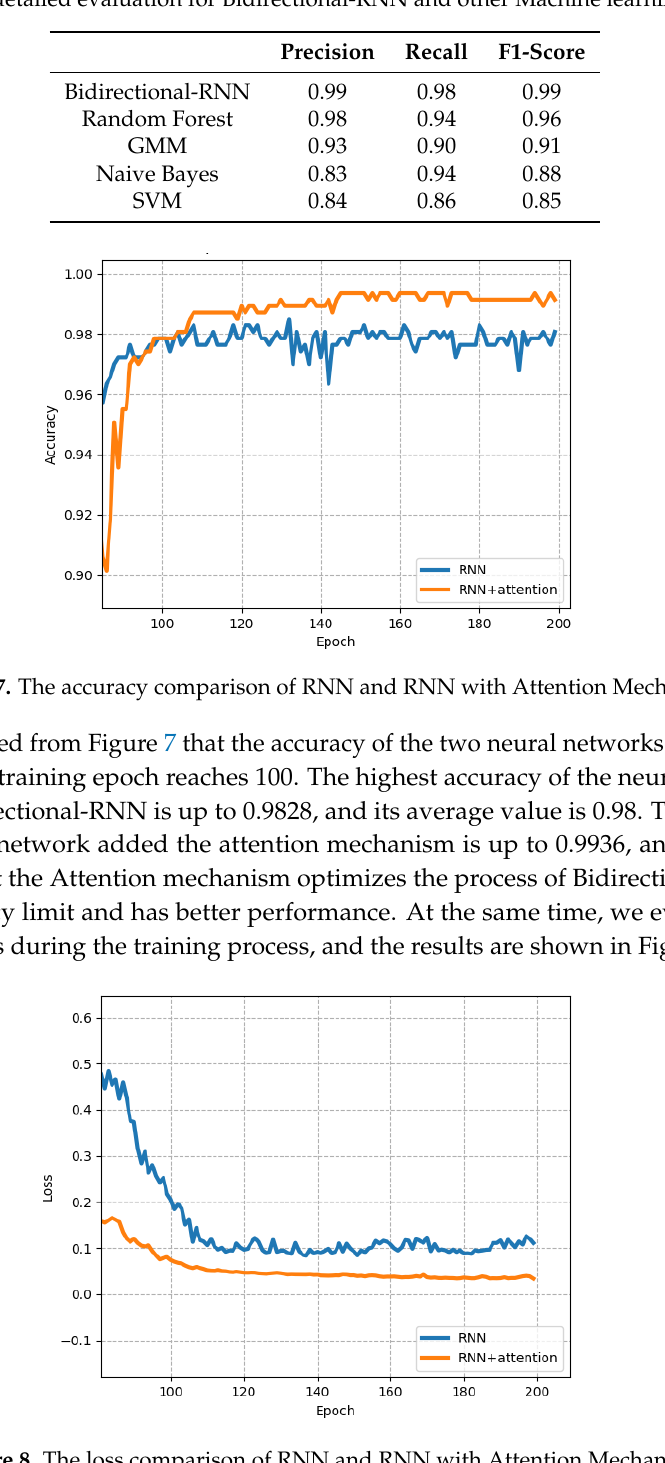
Figure 8. The loss comparison of RNN and RNN with Attention